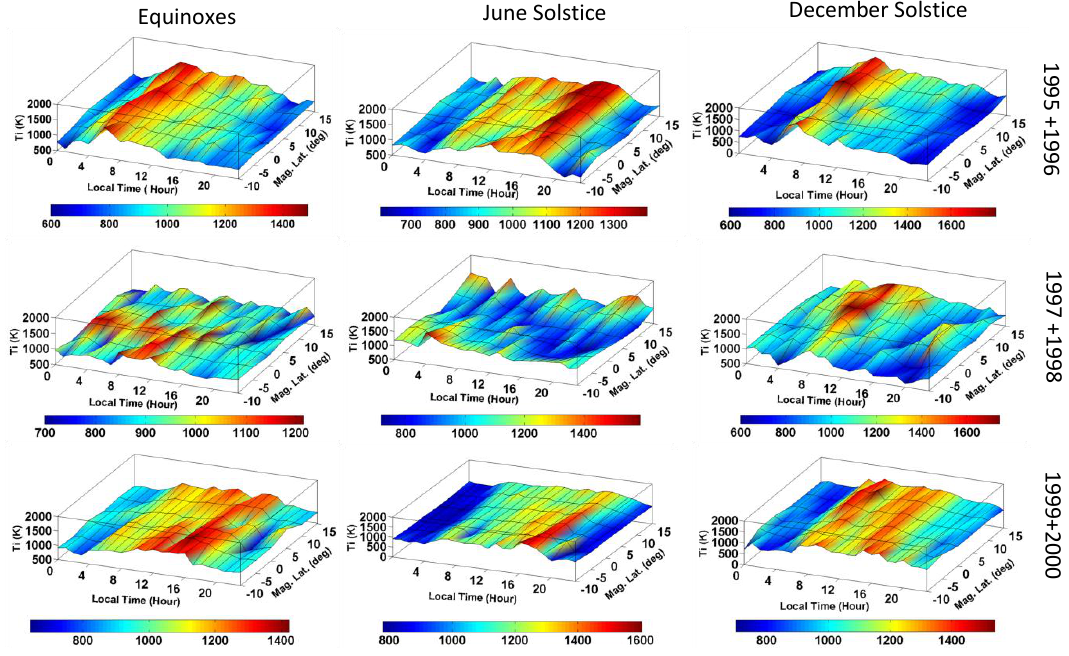
Fig. 1. Three-dimensional plots showing seasonal average ion temperature as a function of magnetic latitude and local time measured by SROCC C2 at 500km altitude in equinox, June and December solstice (from left to right) for the low (1995 and 1996), moderate (1997 and 1998) and high (1999 and 2000) solar activity (top to